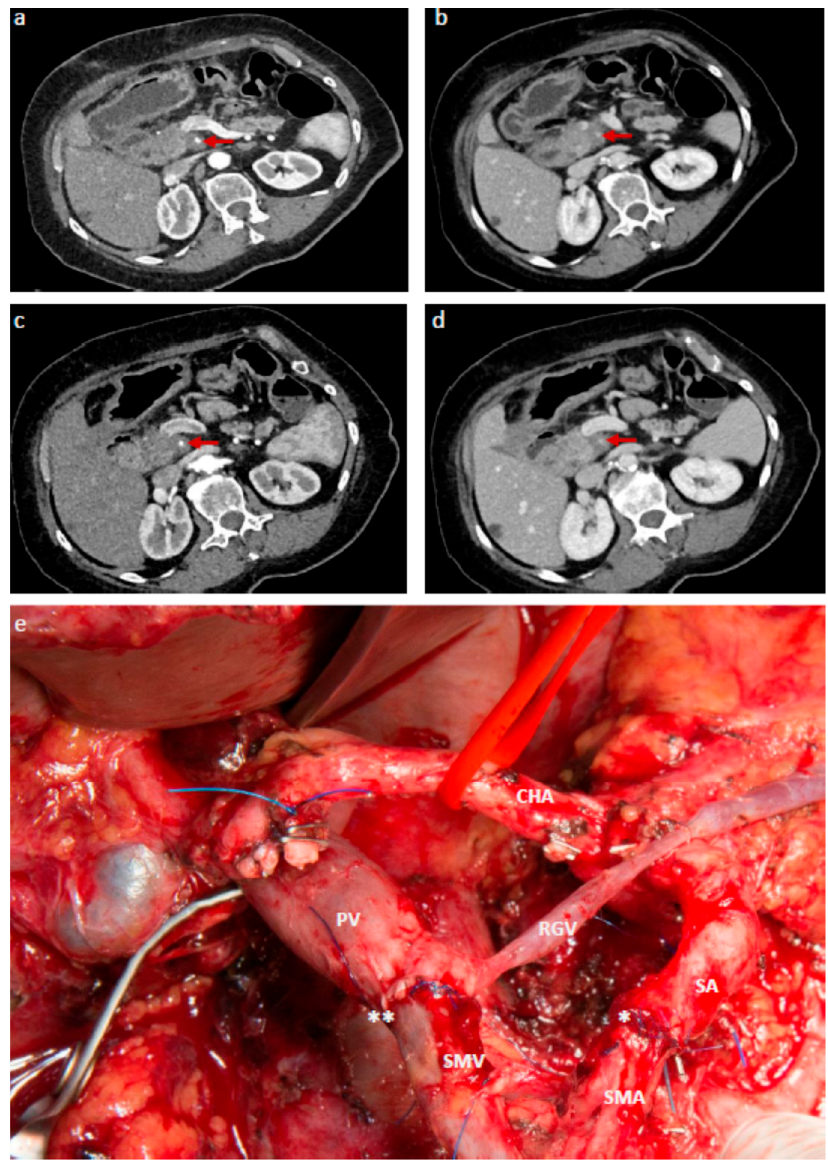
Figure 2. LAPC with stable disease after NAT receiving extended tumor resection with SMA resection: a-d: Transverse multidetector contrast enhanced CT images taken before initiation of NAT ( a , arterial phase; b , venous phase) and after completion of six cycles of Gem-based NAT ( c , arterial phase; d , venous phase). Unresectable PDAC in the pancreatic body with 360 ◦ encasement of the superior mesenteric artery (SMA, red arrow) and occlusion of the superior mesenteric vein (SMV). Stable disease on CT after 5 months ( c and d ). ( e ): Operative site after extended tumor resection with the artery-first approach, total pancreatectomy, splenectomy, subtotal gastrectomy, right hemicolectomy, resection of the portal vein (PV) and SMV with direct end-to-end anastomosis (**). SMA resection was performed with transposition of the splenic artery (SA), indicated with a single asterisk. Final pathology revealed ypT4, ypN2 (4 / 54), V1, L1, R1 with no evidence of disease 19 months after surgery.